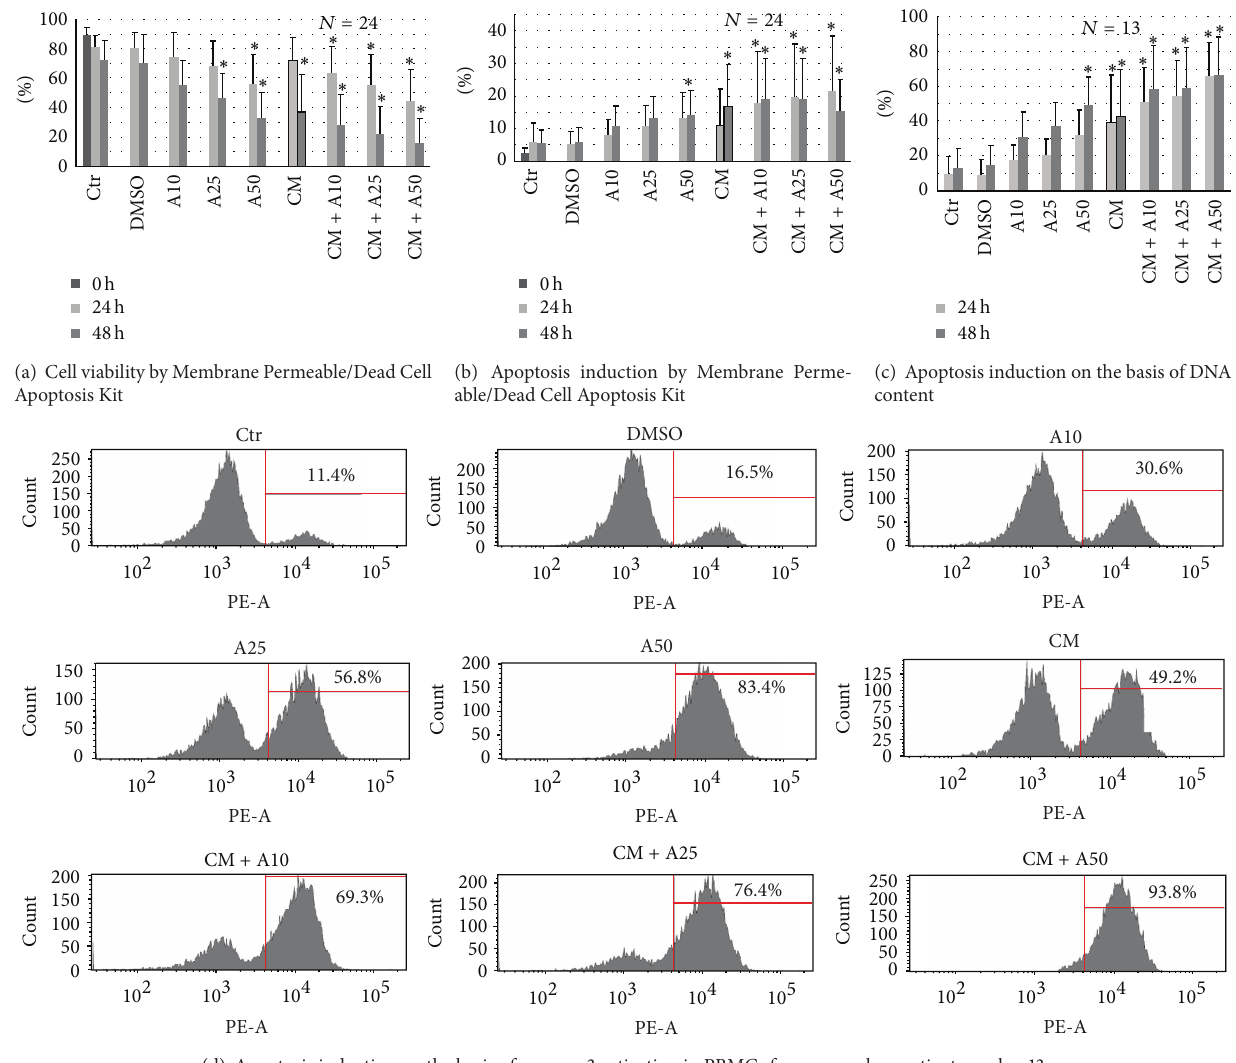
atorvastatin used alone (A), as well as atorvastatin in